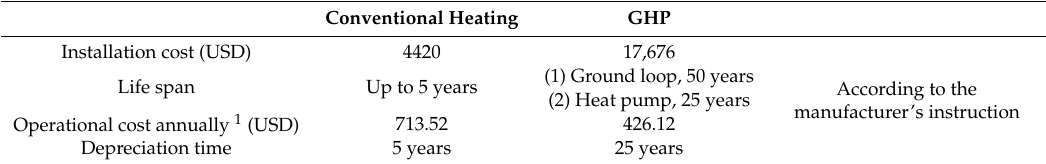
Table 7. Operational and installation cost of the geothermal heat pump (GHP) and a conventional heating system.